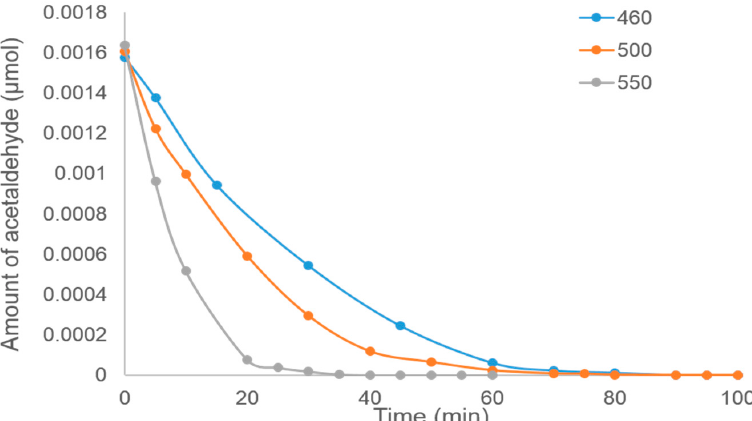
Figure 6. Photocatalytic decomposition of acetaldehyde by using TiO 2 on stainless steel prepared by Spray-ILGAR technique using different heating temperatures (460, 500 and 550 °C), 6.83 mM of TiO 2 precursor and 12 min of spraying time.